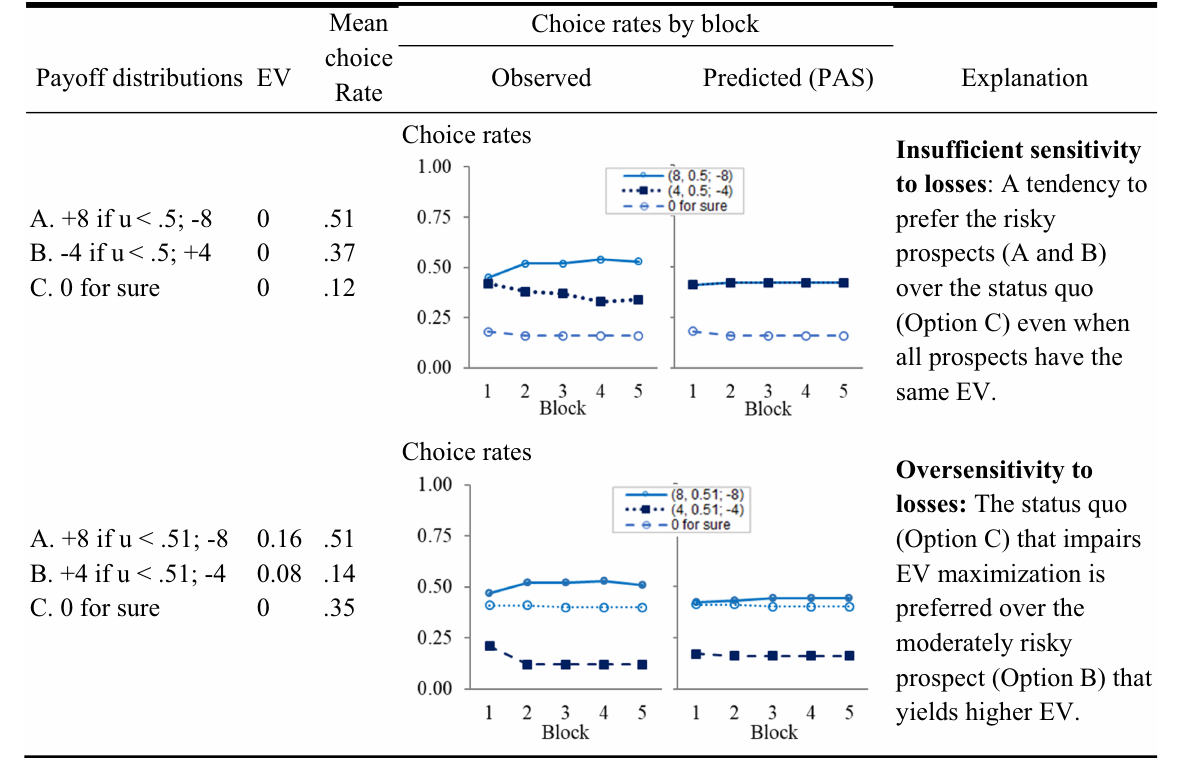
Figure 4’s tasks (when the distribution of parameters is estimated on a different set of tasks and different group of participants).